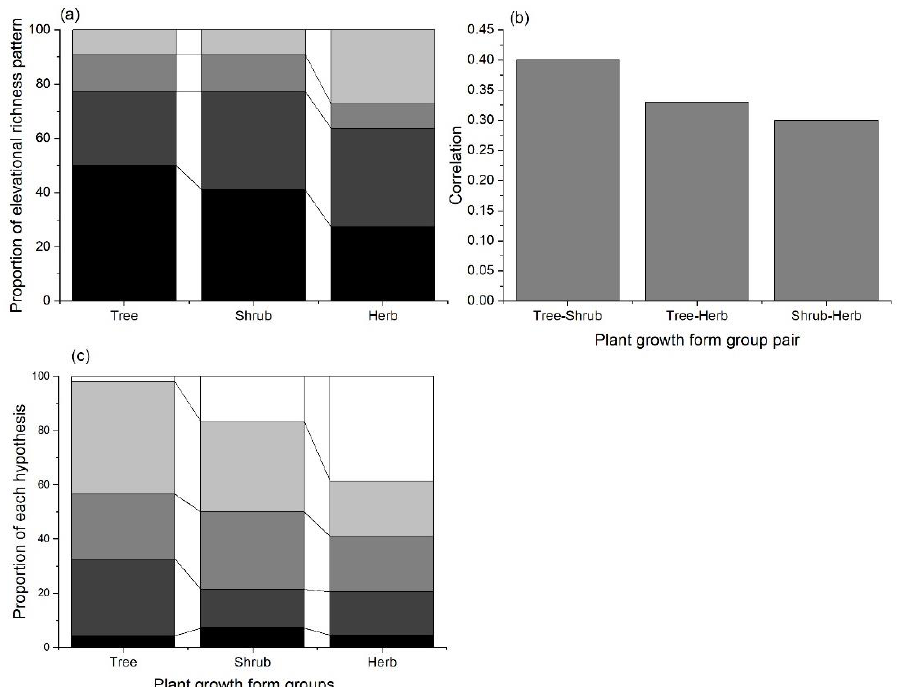
Figure 2. Summary for elevational species richness patterns of plants. ( a ) Proportion of different elevational species richness patterns for each plant growth form group; back: decreasing linearly with elevation; 75% gray: hump-shape with elevation; 50% gray: cubed with elevation; 12% gray: non-significant relationship with elevation. ( b ) Correlation between trees, shrubs, and herbs using the Pearson correlation analysis. The correlation coefficient between the plant groups along the same elevational gradient was calculated. ( c ) The performance of different hypotheses on predicting each elevational species richness patterns, the frequency of occurrence that each hypothesis performed as having the best or second best explanatory power was given; back: area; 75% gray: climatic variability; 50% gray: tolerance; 25% gray: energy; white: unexplainable.